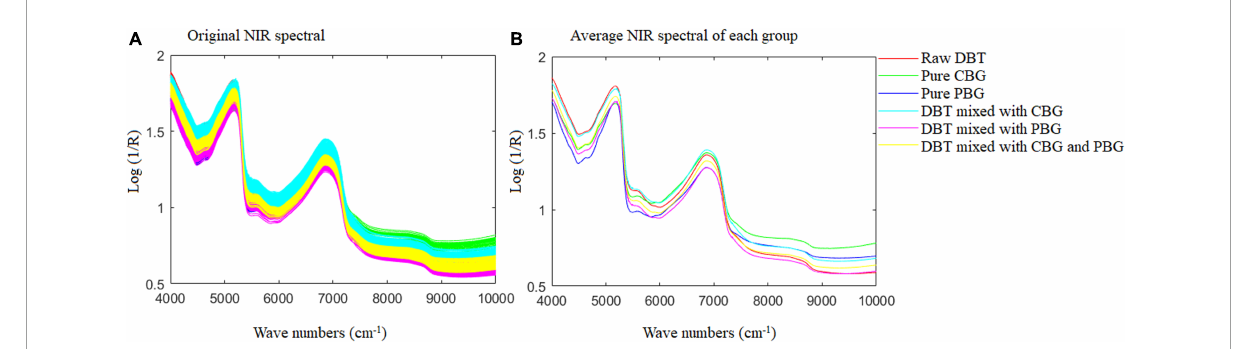
FIGURE1 The original NIR spectral for the samples prepared and used. DBT, Duck blood tofu; CBG, cow blood-based gel; PBG, pig blood